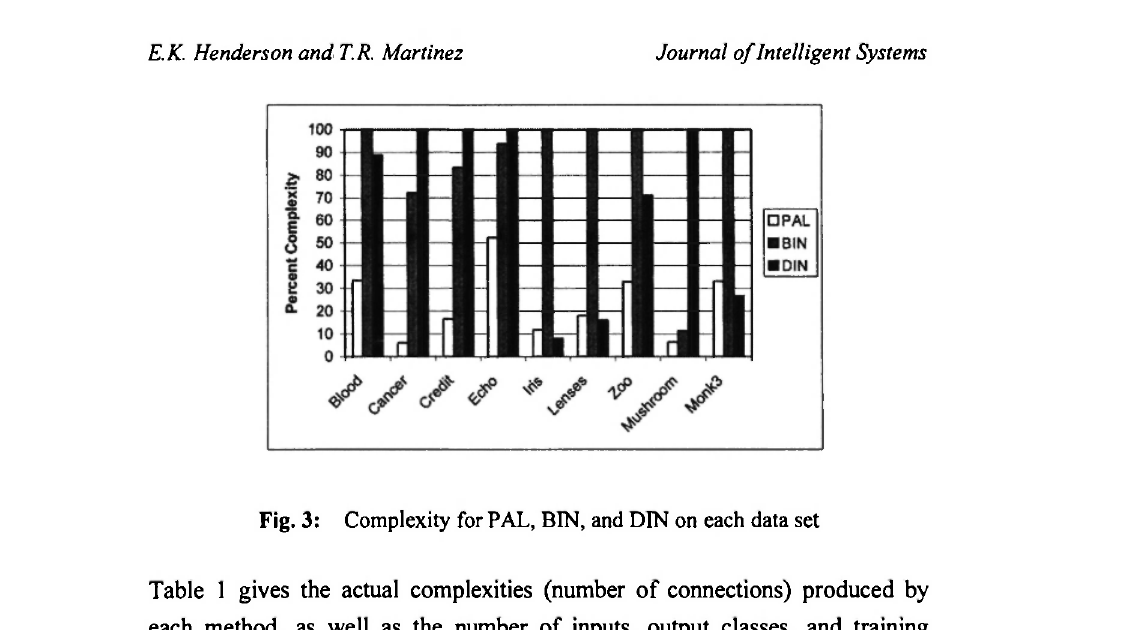
Fig. 3: Complexity for PAL, BIN, and DIN on each data set Table 1 gives the actual complexities (number of connections) produced by each method, as well as the number of inputs, output classes, and training